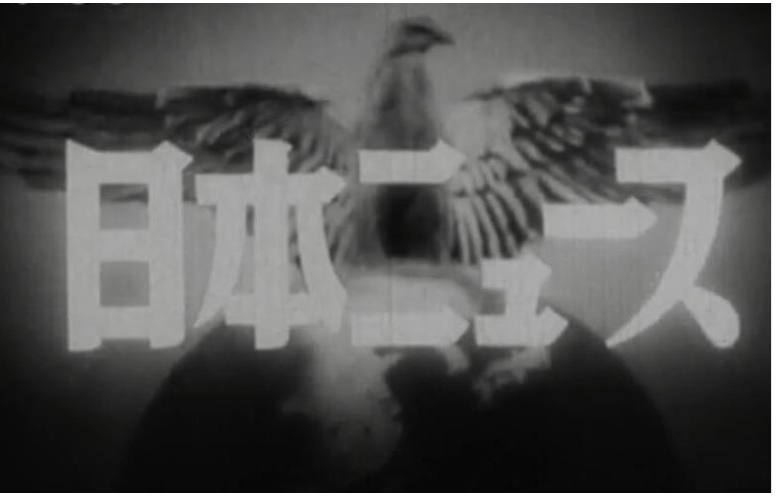
Figure 1. Japanese newsreels’ logo. © NHK Archives.